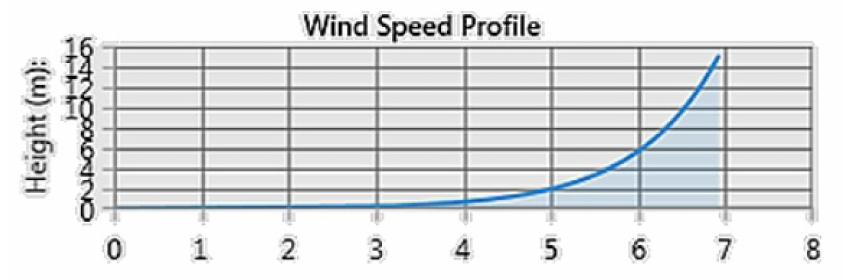
Figure 4. Wind Speed Profile for the Lubuskie Voivodeship—average value. Source: own study using Homer Grid software.